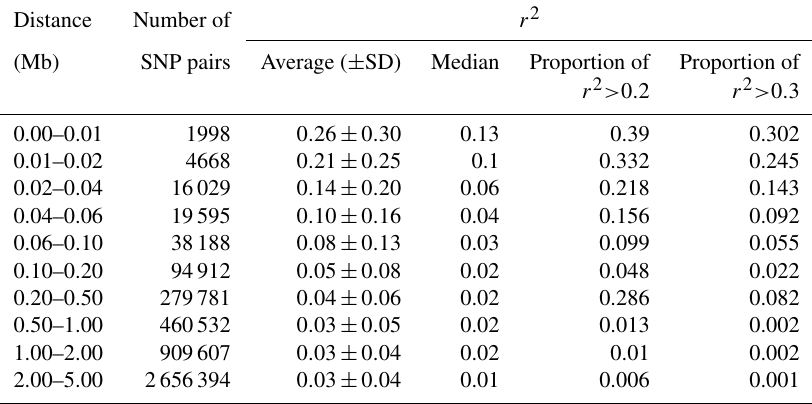
Table 2. Summary statistics of average of r 2 calculated for each distance